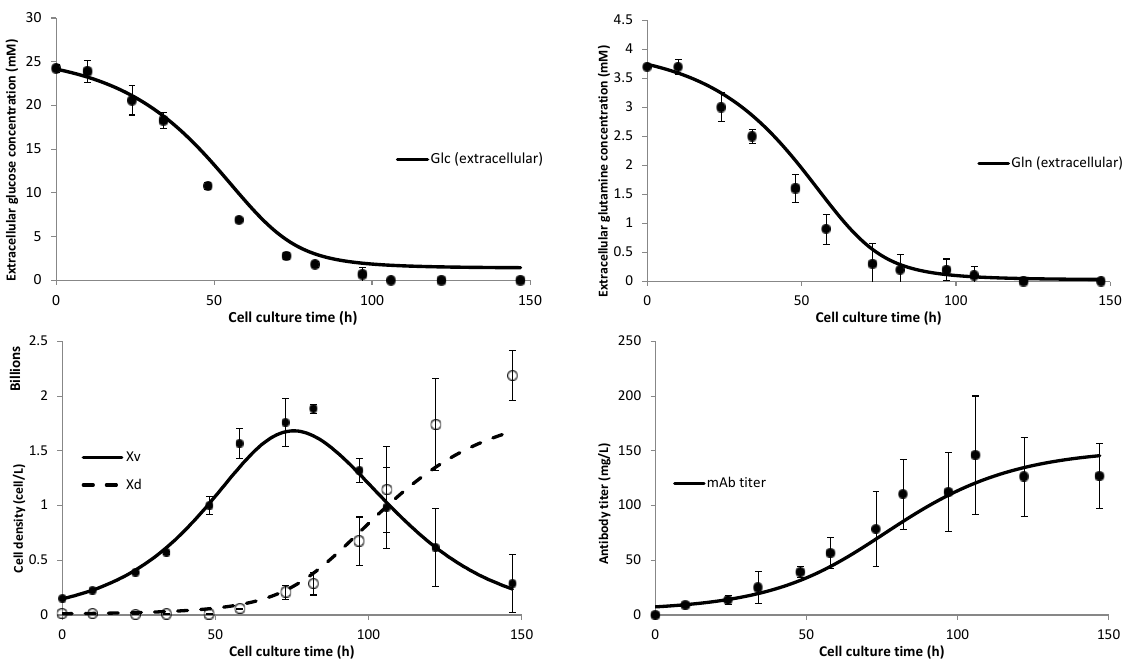
Figure 4. Experimental data compared with generated fits from the dynamic Monod growth model. Fits for extracellular glucose concentration ( top left ), extracellular glutamine concentration ( top right ), viable and dead cell density ( bottom left ) and antibody titer ( bottom right